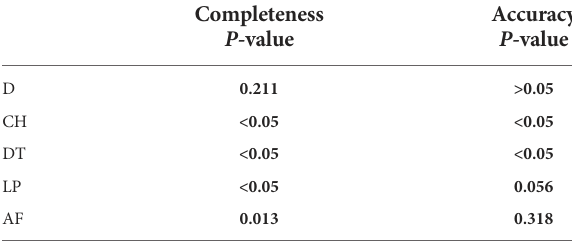
TABLE 7 Comparison of completeness and accuracy for research and educational data values.